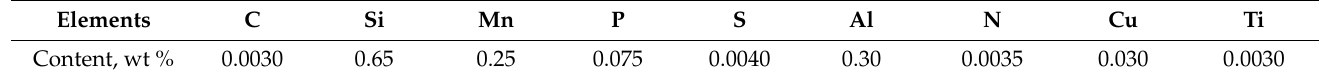
Table 1. Main chemical composition of non-oriented electrical steel.